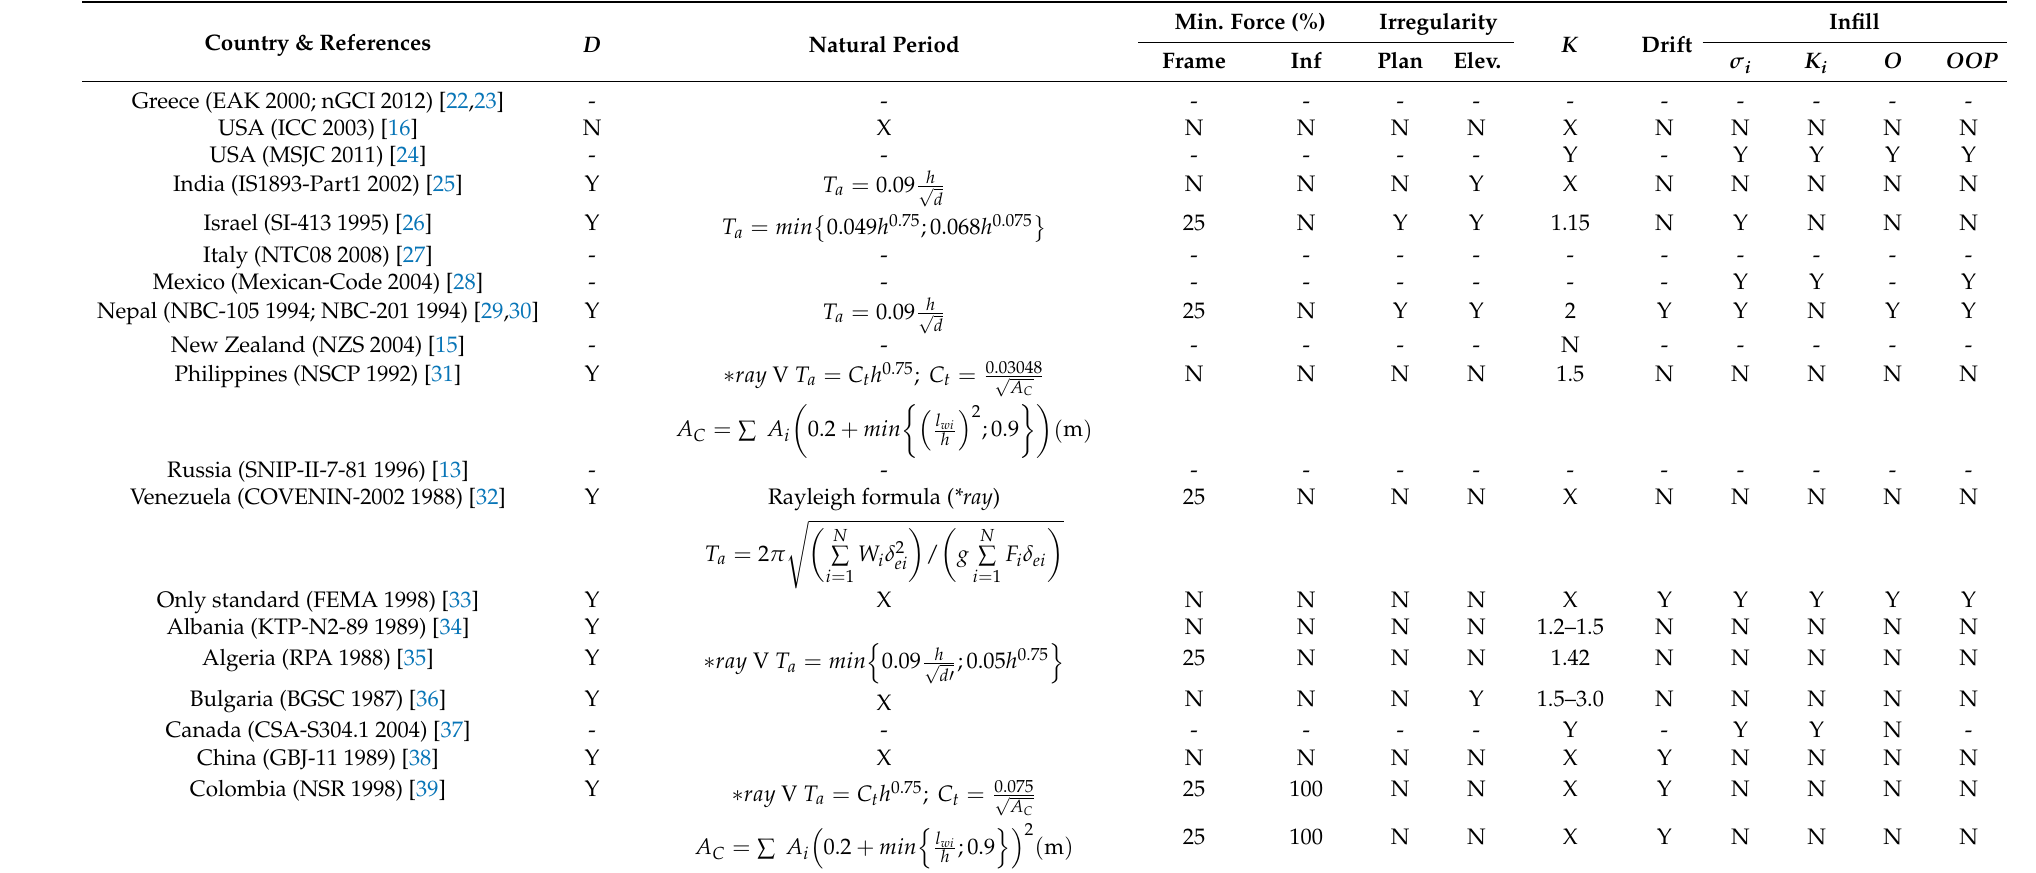
Table 3. Seismic standards on masonry infilled RC frames. (adapted from Refs.